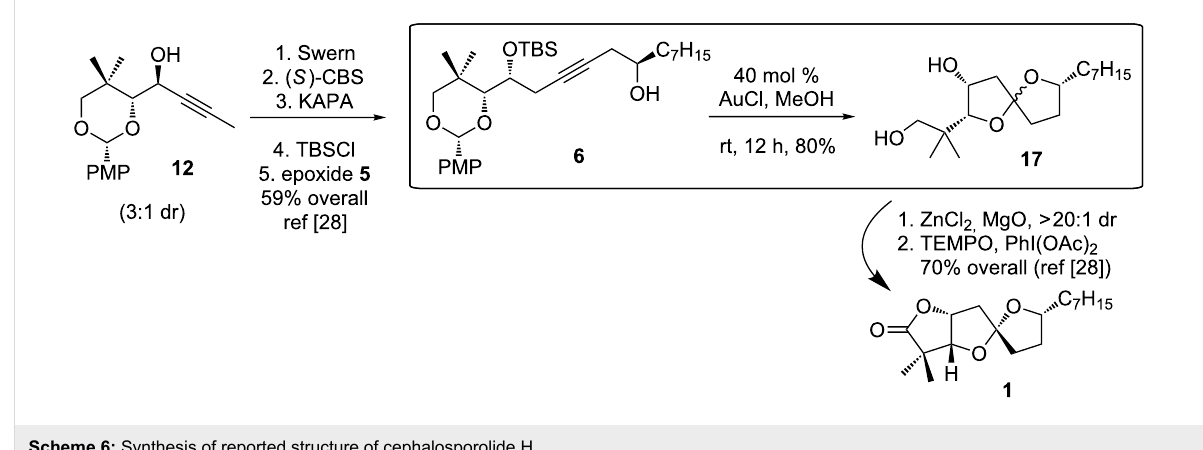
Scheme 6: Synthesis of reported structure of cephalosporolide H.